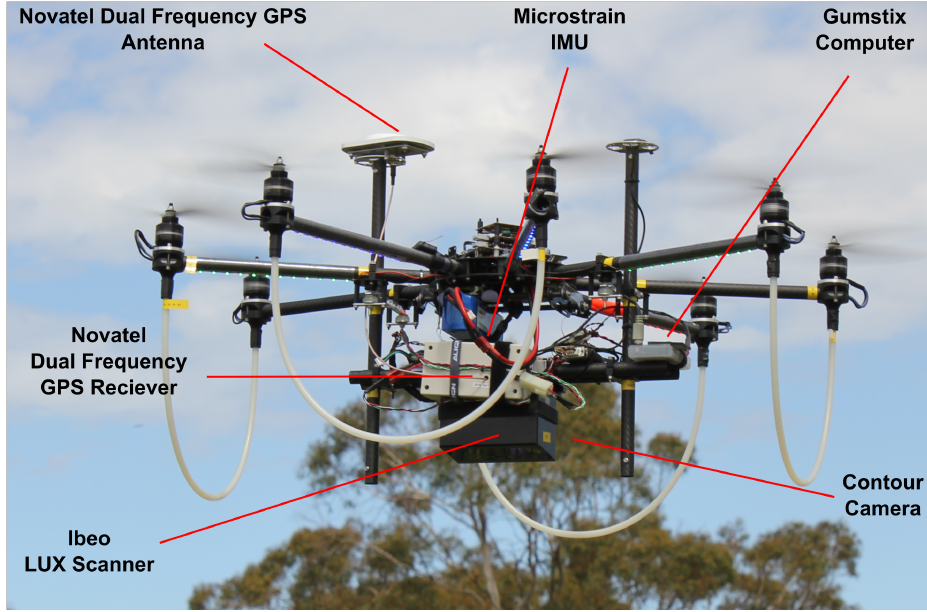
Figure 1. The multi-rotor Oktocopter UAV platform with the vibration isolated sensor frame, carrying the laser scanner, MEMS based IMU, GPS receiver and antenna and video